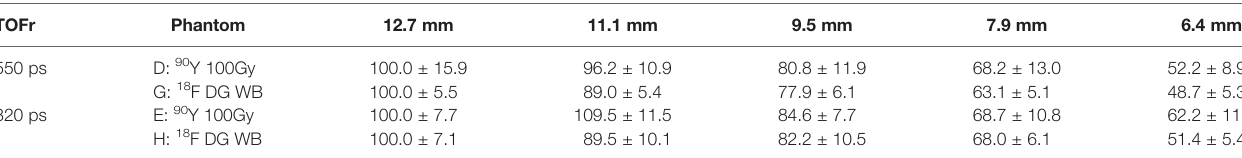
Prompts (P) and randoms (R) correspond to the counts recorded in the prompt and delayed coincidence window. S was estimated as 0.35 (P-R). (Mcts: megacounts). See the Supplementary File for an SNR curve TABLE 2 | Mean and variance of the counts per pixel normalized to 100 for the largest hot rod sector of each setup for the two different TOF resolution (TOFr) systems. TOFr Phantom 12.7 mm